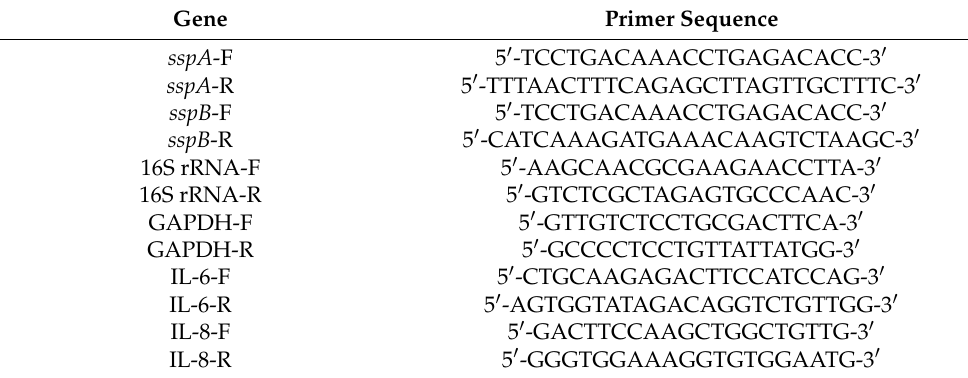
Table 1. Primer sequences of the differentiation markers.